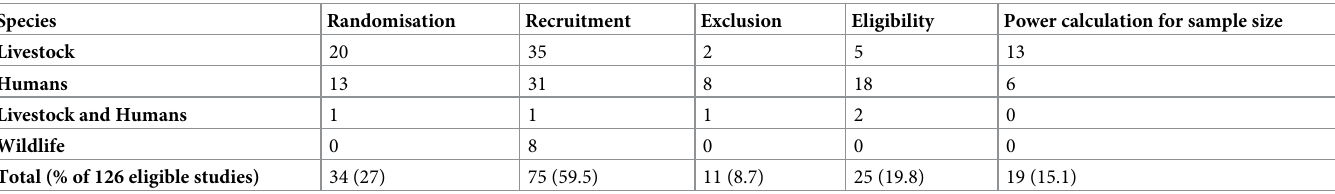
Table 4. Number of Rift Valley fever virus seroprevalence articles in Africa accounting for risk of bias outlined in the STROBE statement.